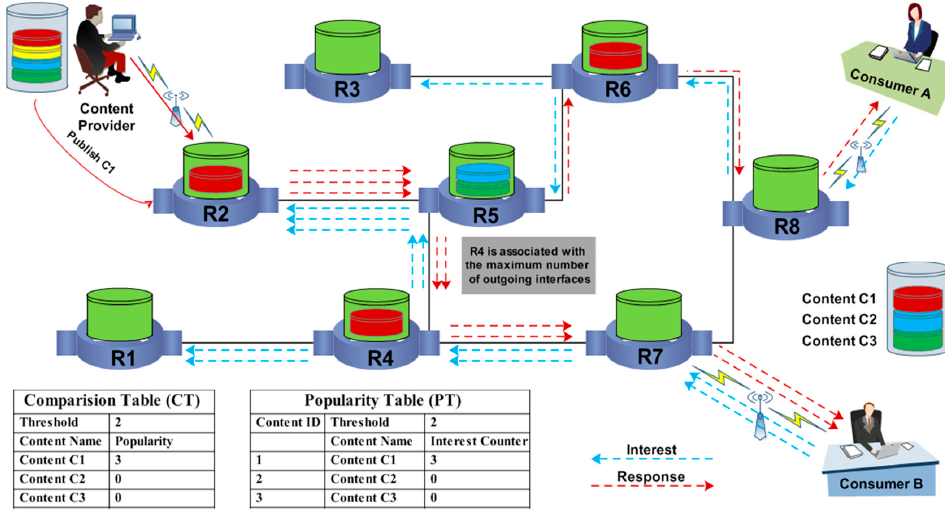
Figure 3. Flexible Popularity-based Caching Strategy.